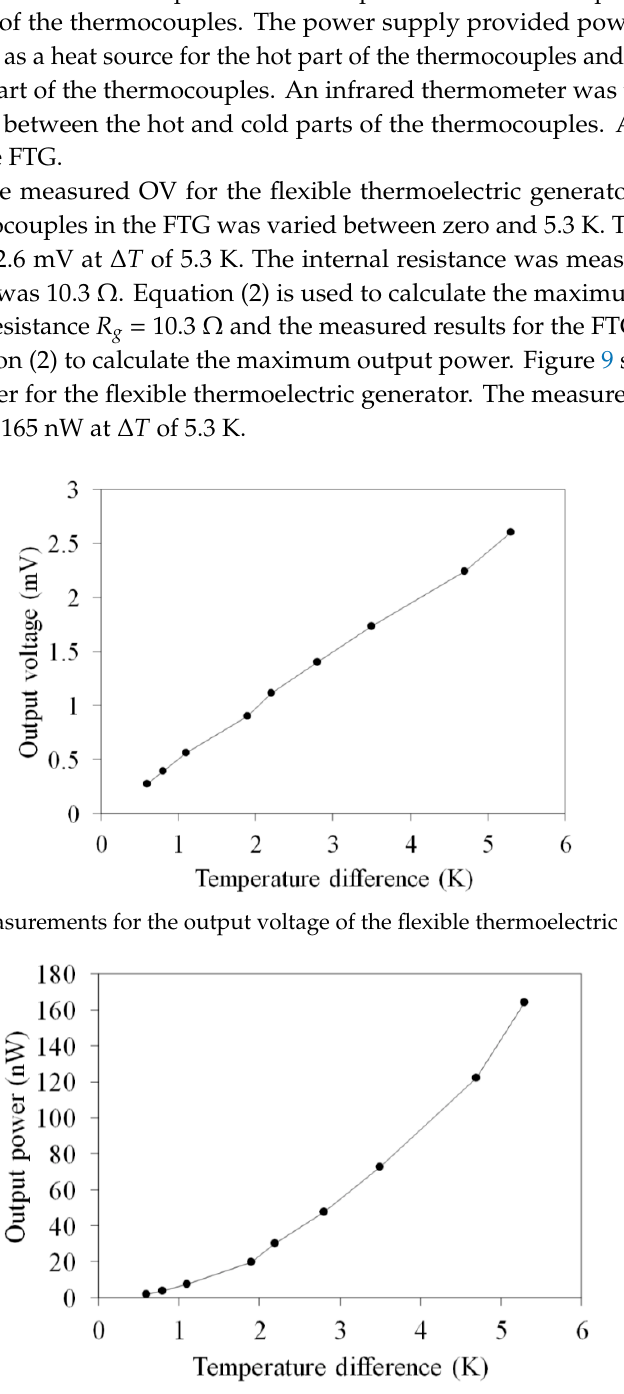
Figure 9. Measurements for the output power of the flexible thermoelectric generator.